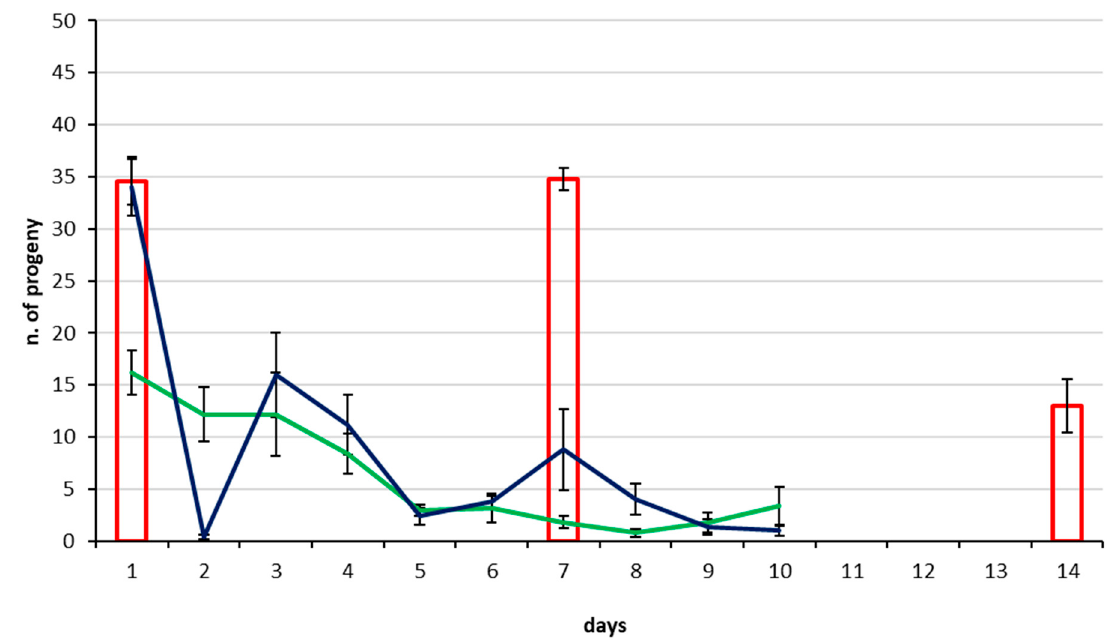
Figure 3. Mean number (±S.E.) of progeny produced by Trissolcus mitsukurii CREA colony under different supply regimes of Halyomorpha halys host egg masses. Green line = 1-day-old females with host egg masses offered daily for 10 consecutive days (1 d × 10 d); blue line = 7-day-old females (host deprived until day 7) with host egg masses offered daily for 10 consecutive days (7 d × 10 d); histograms = 7-day-old females (host deprived until day 7) with host egg masses offered once a week for three consecutive weeks (7 d × 3 w); see text for more details.